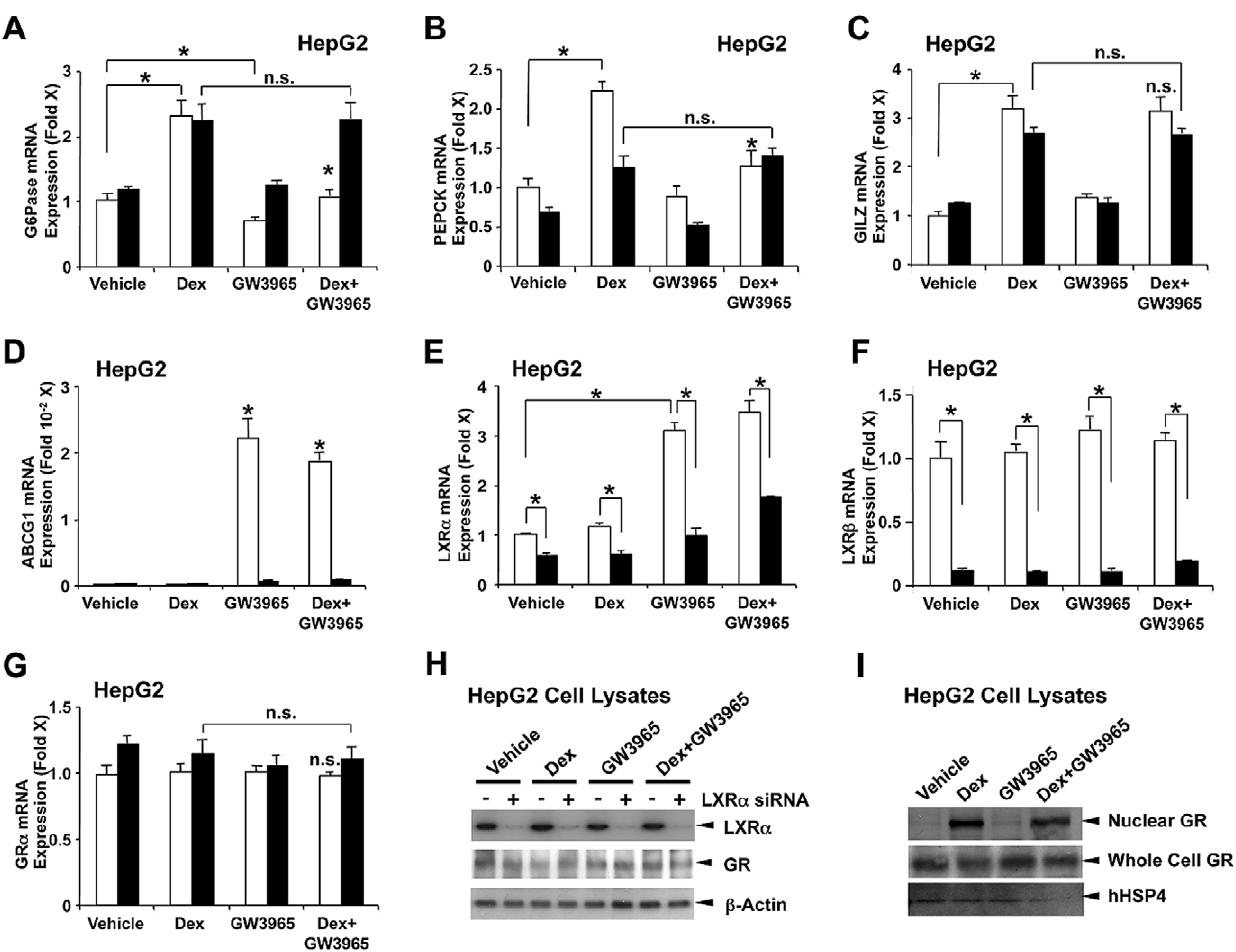
Figure 3. Ligand activation of endogenous LXRs differentially regulates dexamethasone-induced mRNA expression of glucocorticoid-responsive genes in a gene-specific fashion. A, B, C, D, E, F and G. HepG2 cells were transfected with negative control siRNA for luciferase GL2 (white bars) or siRNAs for LXR a / b (black bars), and were treated with or without 10 2 6 M dexamethasone and/or 10 2 6 M GW3965. Total RNA was harvested and mRNA levels of G6Pase (A), PEPCK (B), GILZ (C), ABCG1 (D), LXR a (E), LXR b (F) and GR (G) were measured with the SYBR-Green real-time PCR. Bars represent mean 6 S.E. values of the fold induction of mRNA expression. *: p , 0.01, n.s.: not significant compared to the condition transfected with the control siRNA in the presence of dexamethasone or between the two conditions indicated. Dex: dexamethasone. H. siRNAs for LXR a suppress expression of LXR a protein in HepG2 lysates. HepG2 cells were transfected with negative control siRNA for luciferase GL2 or siRNAs for LXR a , and were treated with or without 10 2 6 M dexamethasone and/or 10 2 6 M GW3965 for 24 hours, and cells lysates were prepared. hLXR a ( upper panel ), hGR ( middle panel ) and h b -actin ( lower panel ) were visualized with their specific antibodies in Western lots. I. Ligand activation of endogenous LXRs does not influence dexamethasone-induced translocation of GR from the cytoplasm into the nucleus. HepG2 were treated for 2 hours with or without 10 2 6 M dexamethasone and/or 10 2 6 M GW3965. Whole cell lystates and nuclear extracts were run on 4–20% SDS-PAGE gels, blotted to nitrocellulose membranes and hGR ( upper panel : nuclear GR, middle panel : whole cell GR) and hHSP4 ( lower panel ) were visualized with their specific antibodies in Western blots.